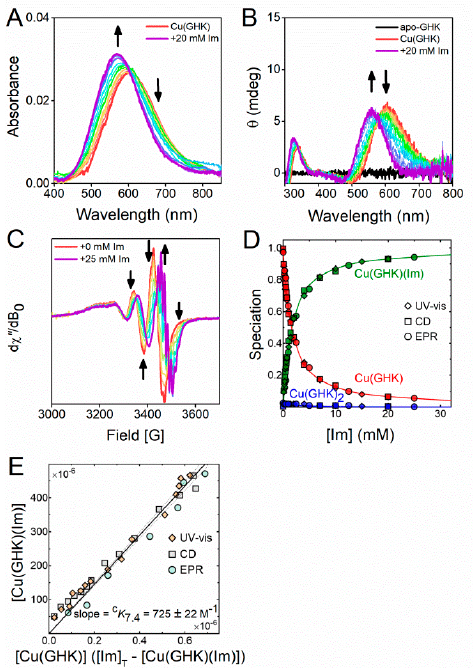
Figure 3. The conditional Cu(II) binding constant c K 7.4 = [Cu(GHK)(Im)] / ([Cu(GHK)][Im]). ( A ) UV-vis, ( B ) CD, and ( C ) EPR spectra of Cu / GHK / Im 0.5:0.63: n (0 ≤ n ≤ 25 mM) at pH 7.4, 25 ◦ C. ( D ) Speciation of GHK complexes obtained from decomposition of UV-vis, CD, and EPR spectra in dependence of Im concentration (Figures S8–S11). ( E ) Determination of the binding constant c K 7.4 using least squares regression. The margin of error derives from the 95% confidence interval (dashed